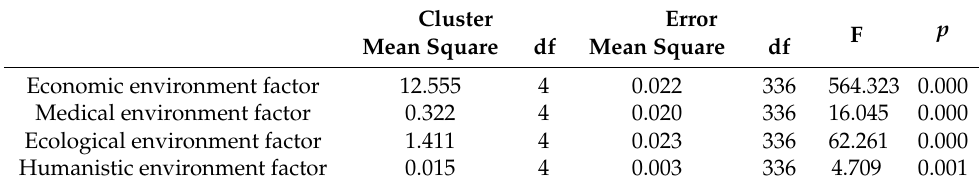
Table A7. Analysis of variance.